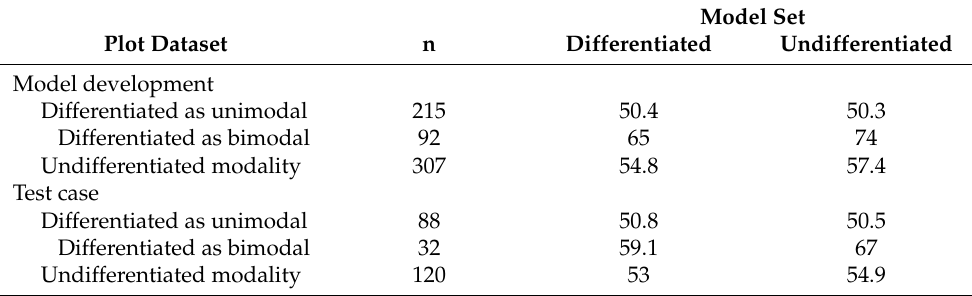
Figure 5. Cumulative variable importance values for metrics used in the best SDD parameter models which used M comb during model development. Individual values represent the average variable importance across the three modelling techniques within each parameter and was scaled between 0 and 1. Only metrics with a cumulative value > 3 are shown. Asterix (*) denotes metrics originating from M tex . Table 3. Plot-level Reynold’s Error Index means for each ground plot dataset and model set. EI values ranged between 0 and 200, where an EI of 0 indicated a perfect fit between predicted and observed SDD, which an EI of 200 indicated a completely different